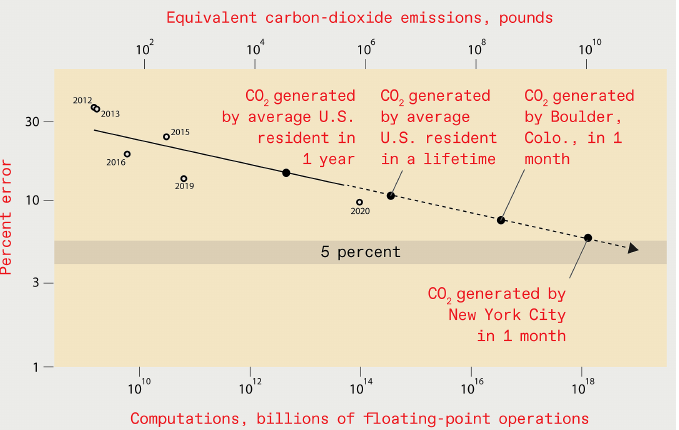
Figure 1. Comparing the computing resources and energy required to train a DNN system to recognise objects in the ImageNet dataset with an error rate of 5%. The amount of CO 2 emitted would be as much as New York City generates in one month. Figure courtesy of Thompson et al. [4]. Table 1. Estimated CO 2 emissions from training common NLP models, compared to familiar consumption. Table courtesy of Strubell et al. [2], with original sources for air travel and per- capita consumption: https://bit.ly/2Hw0xWc (accessed on 2 December 2021), and car